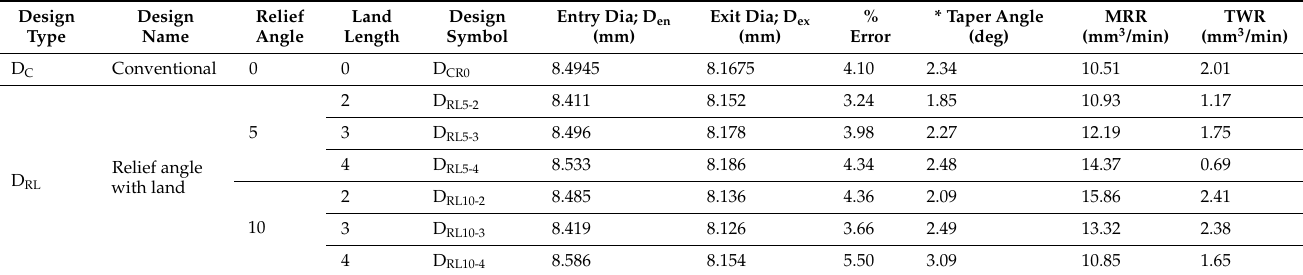
Table 6. Experimental results of stage-2 experimentation.